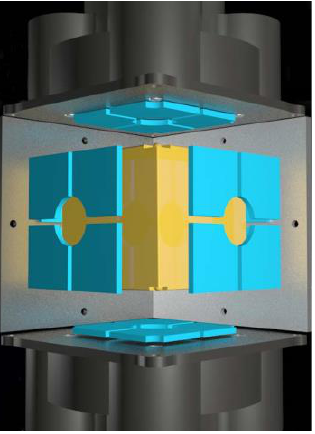
Figure 5. Distribution schematics of the 12 pairs of electrodes.